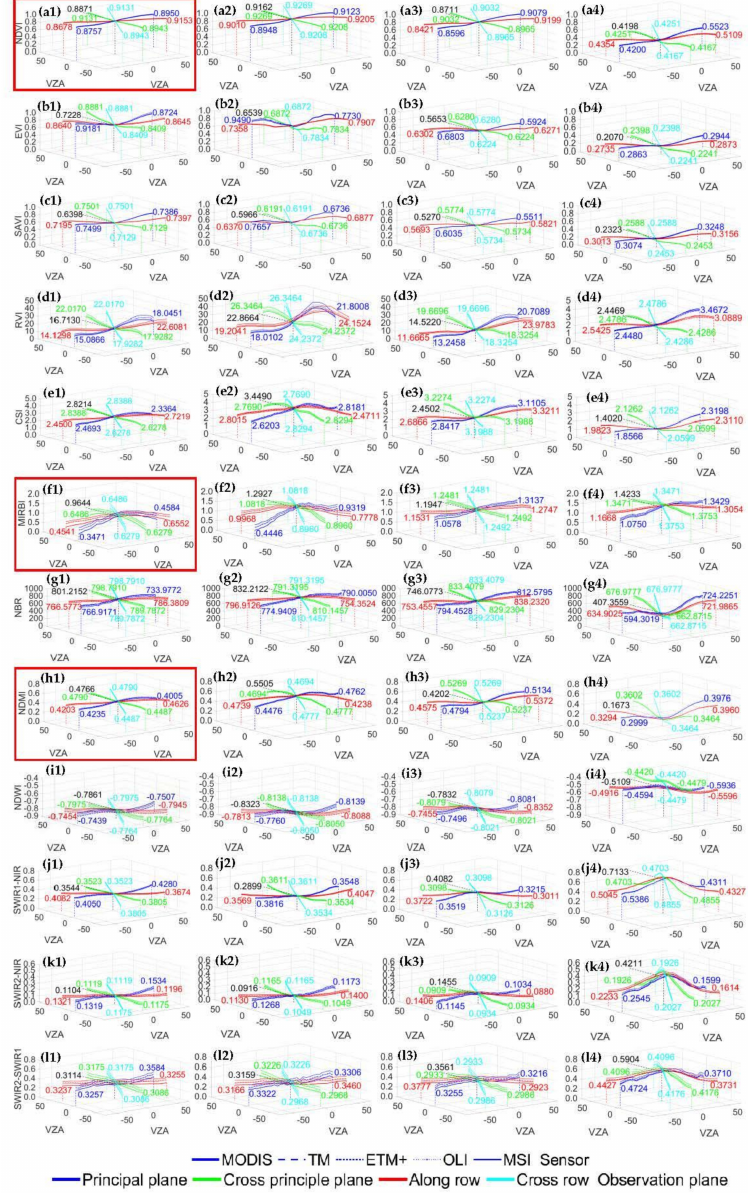
Figure 10. Variation in 12 indices calculated from simulated sensor-like spectra and noted by vertical axis annotation of sub-figures through ( a – l ) with cases respectively on 17 April (jointing stage), 3 May (booting stage), 20 May (filling stage), and 9 June (wax maturity stage) at columns from left to right ( 1 – 4 ) in the principal (blue), cross-principal (green), along-row (red), and cross-row (cyan) planes under view zenith angles varying within [ − 70 ◦ , +70 ◦ ] in the XOY plane for MODIS (bold solid line), TM (dash line), ETM+ (dotted line), OLI (dash dotted line), and MSI(light solid line). The magnitude of indices is labeled at ± 65 ◦ ( ± 60 ◦ ) VZA by vertical lines with the related color in each plane and accompanied by a black vertical line at the nadir view